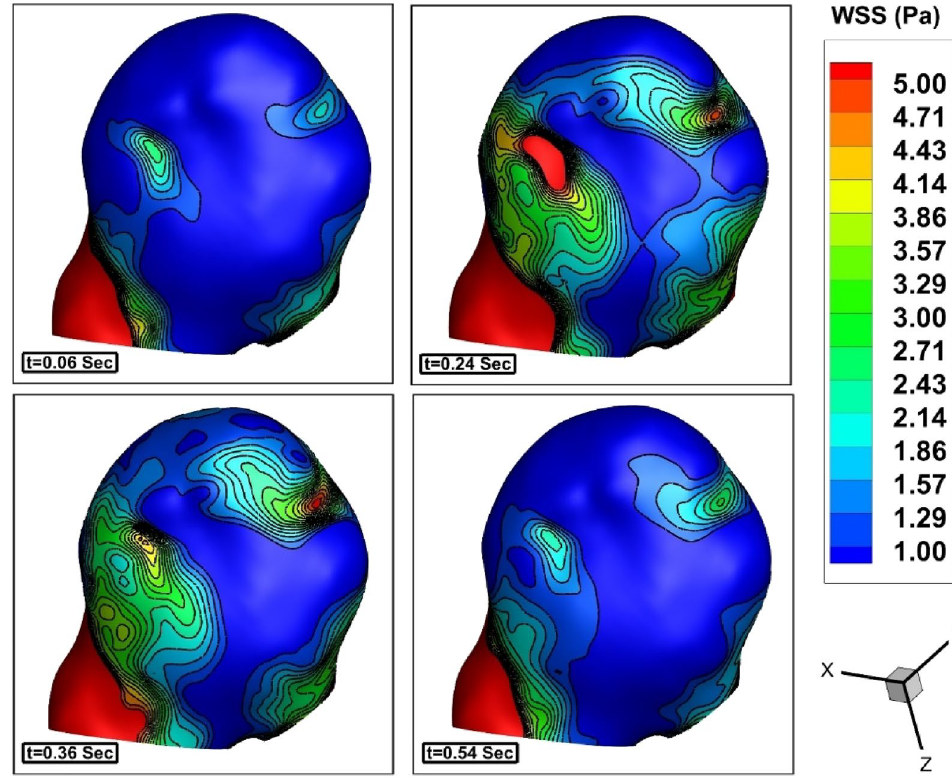
Figure 5. Variation of the WSS on the sac wall in different stages of blood